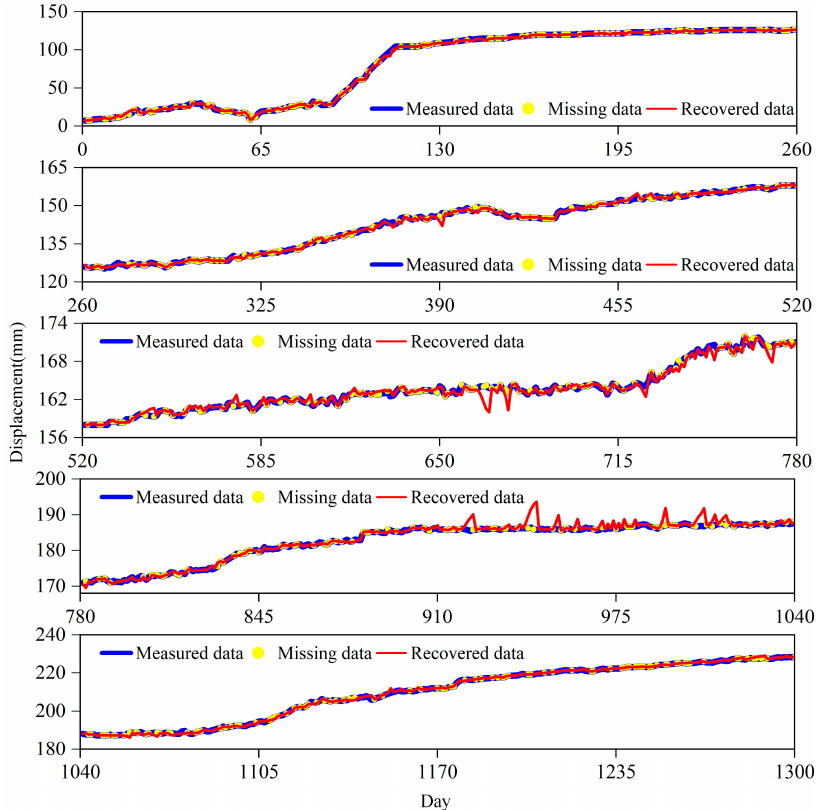
Figure 6. Completion of the displacement data of SZY-08 (RM40%). The blue curve represents the measured data, the yellow dots represent the missing data and the red curve represents the recovered data.